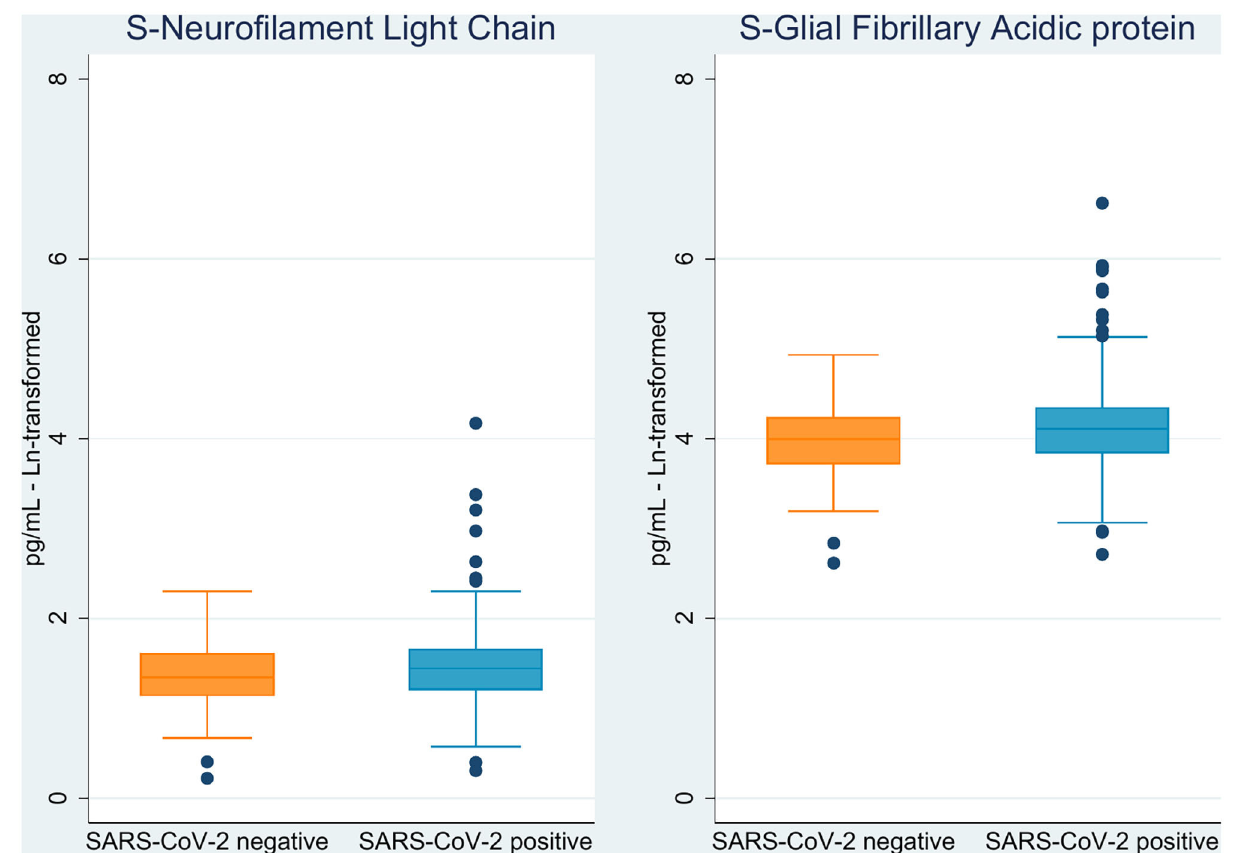
FIGURE 2 | Boxplot of brain injury biomarkers according to SARS-CoV-2 status.